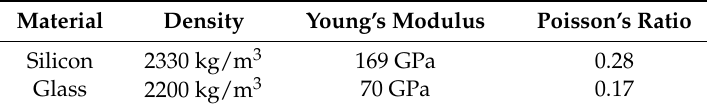
Table 3. Main material properties of the device